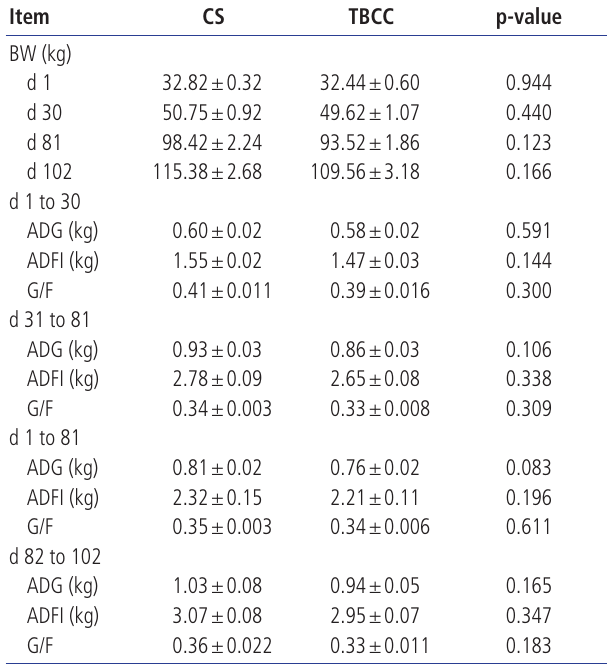
Table 2. Effects of copper sulfate (CS) and tribasic copper chloride (TBCC) on the growth performance in pigs Item CS TBCC